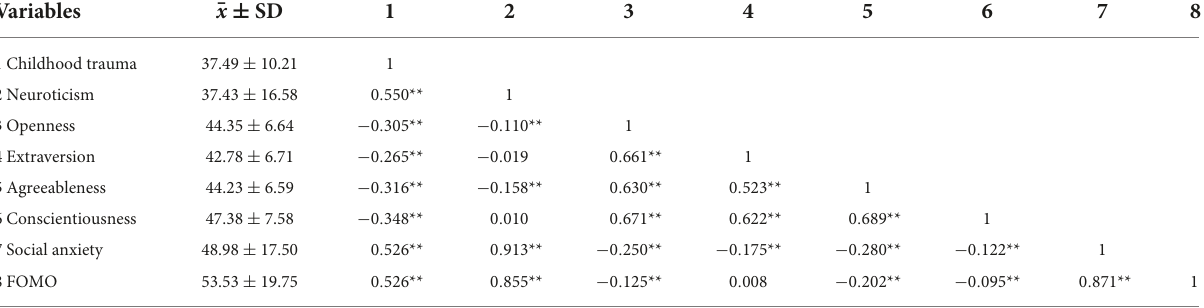
TABLE 1 Correlation between childhood trauma, neuroticism, social anxiety, and the fear of missing out (FOMO).